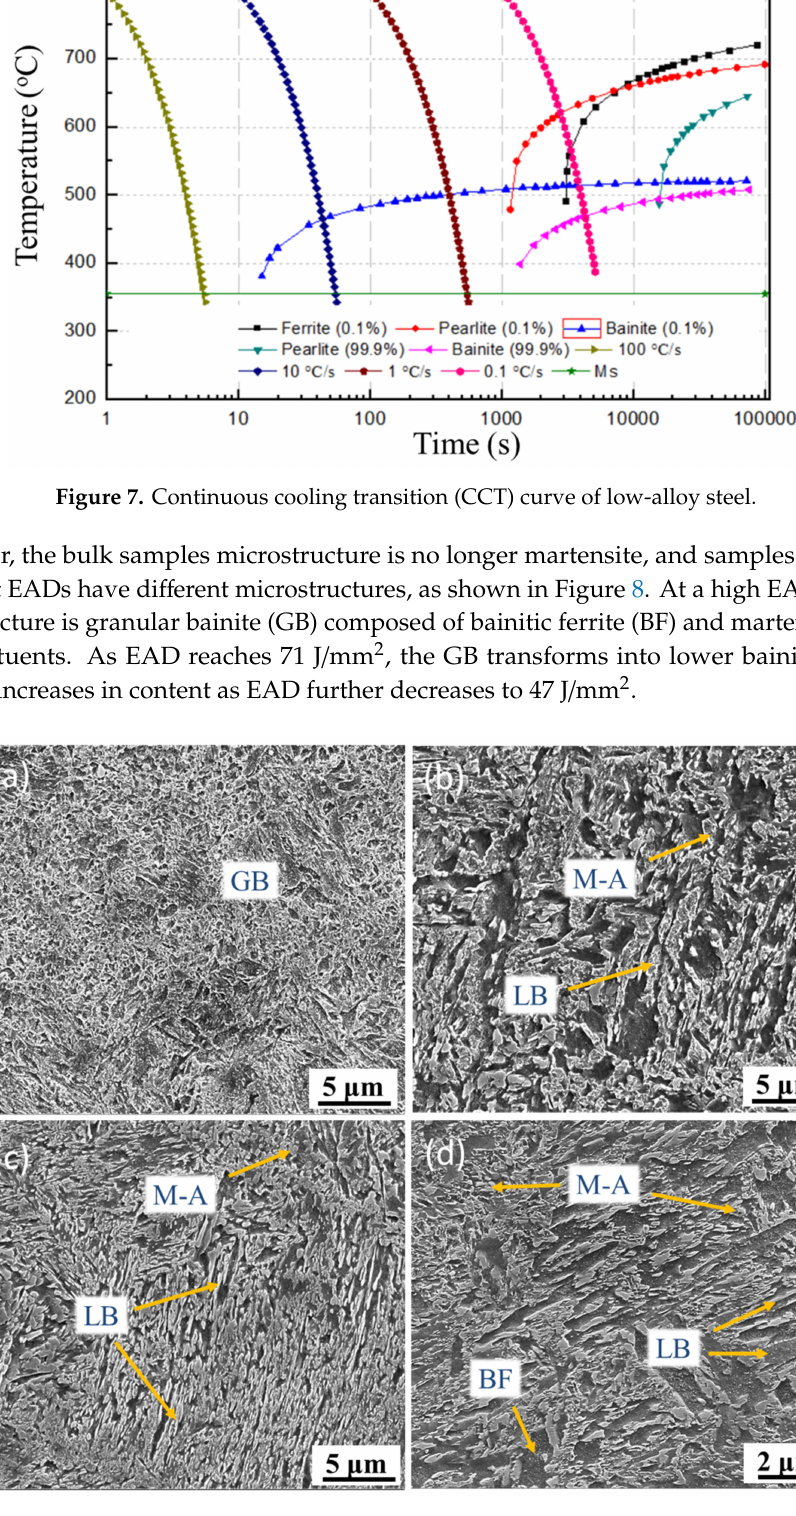
Figure 8. Microstructures of SLM low-alloy steel samples grown with di ff erent EADs: ( a ) EAD = 142 J / mm 2 ; ( b ) EAD = 71 J / mm 2 ; ( c ) EAD = 47 J / mm 2 ; and ( d ) zoomed-in image of ( b ). GB: granular bainite; M-A: martensite–austenite; LB: lower bainite; BF: bainitic